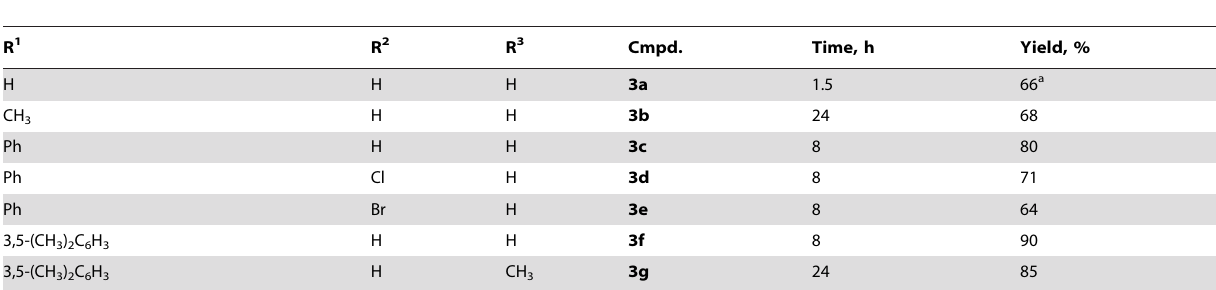
Table 1. Scope and yields of the CAN-promoted Friedla¨nder synthesis of luotonins.